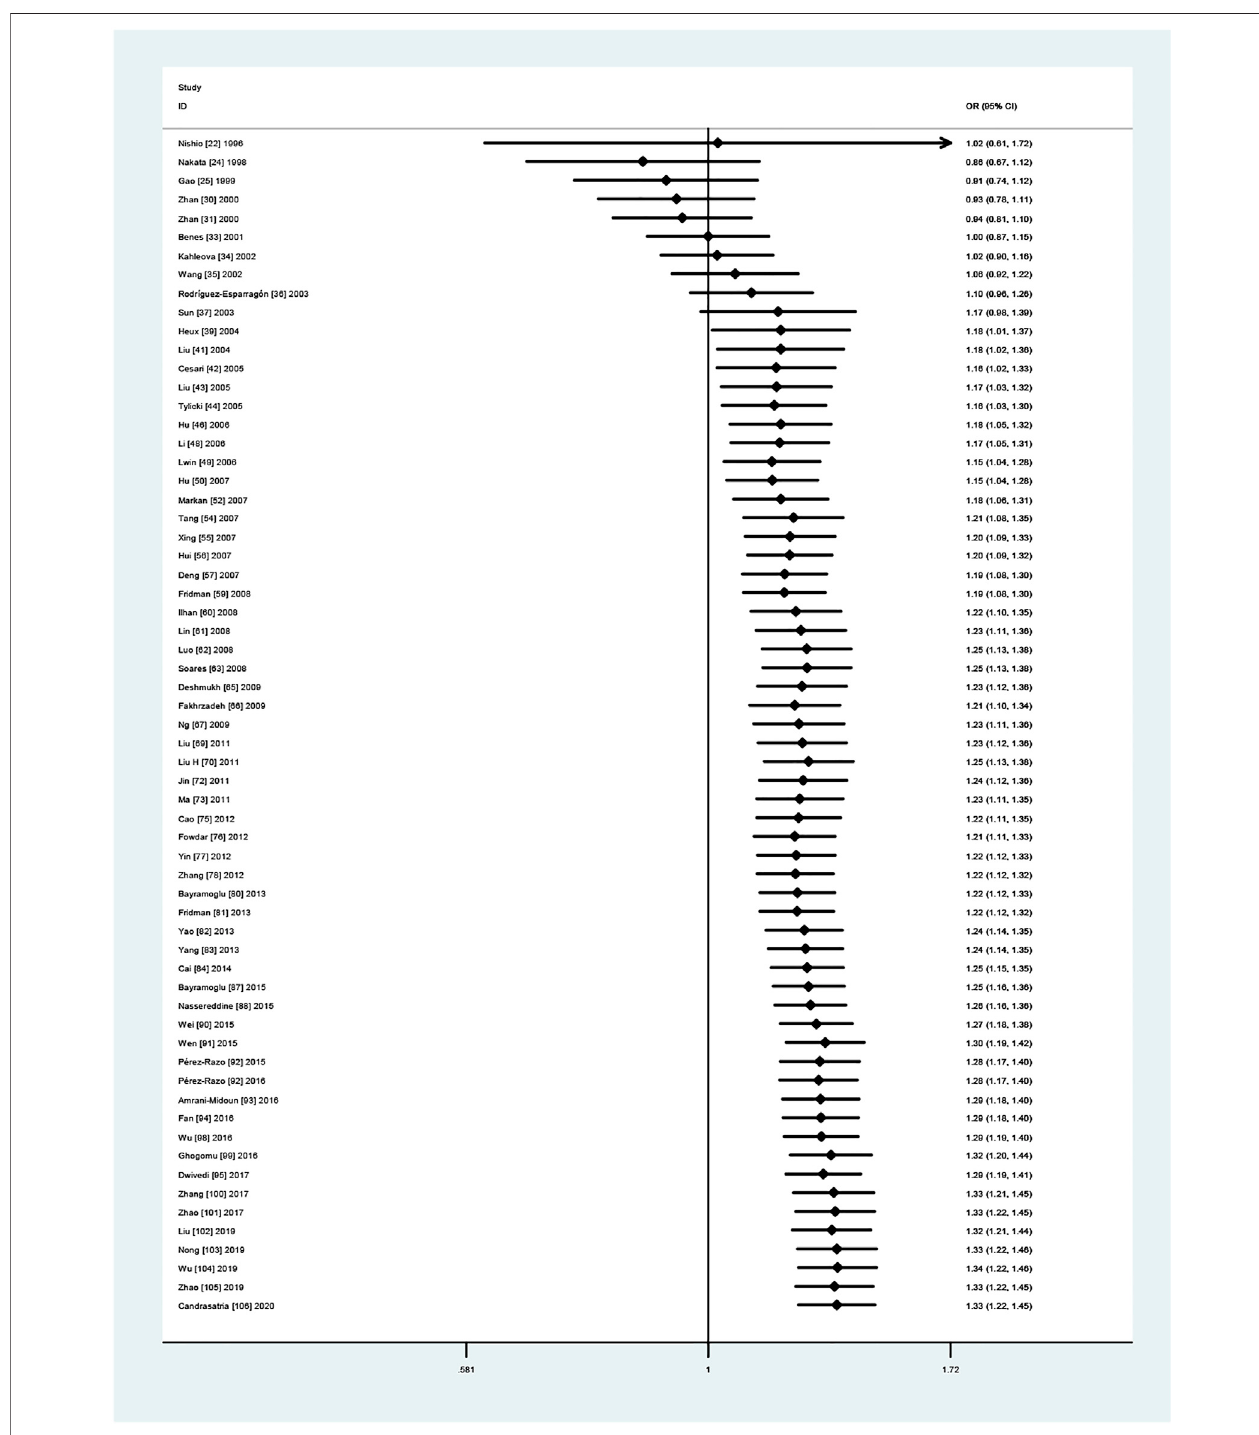
FIGURE 4 | A cumulative meta-analysis of forest plots was performed based on years (allelic model, T vs. C).